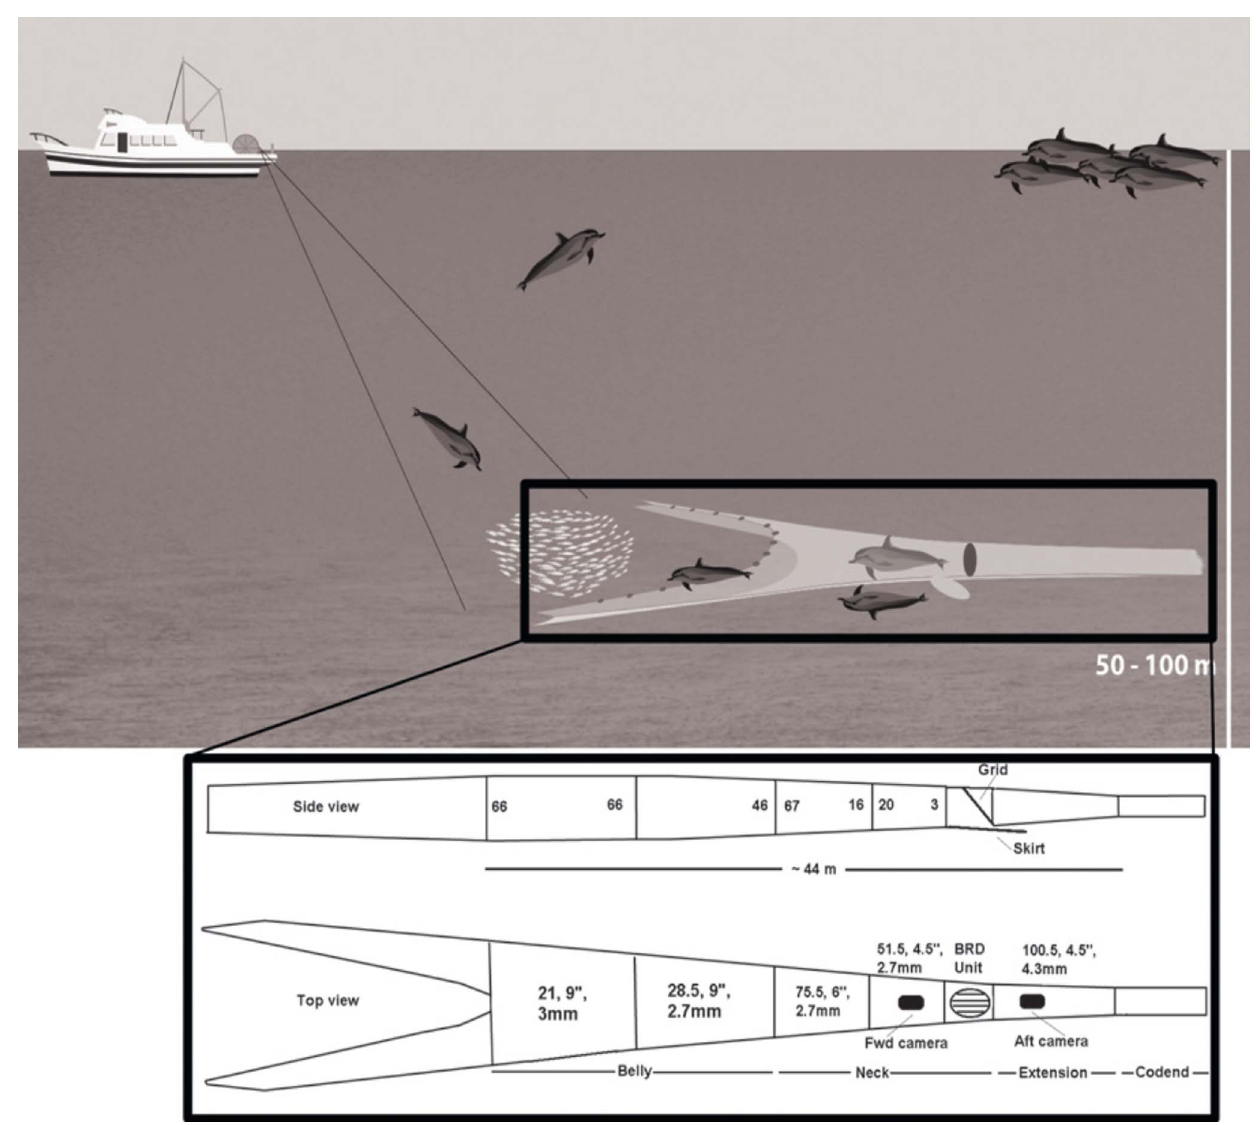
Figure 2. Schematic of trawler and trawl net on or near the seabed. Also illustrated are the typical positions of dolphins in and around the net, as well as following the trawler on the surface. The detailed net diagram represents the typical net specifications used in the Pilbara Trawl Fishery in 2008 and 2009, showing the side and top views, location of the Bycatch Reduction Device and the skirt covering the escape hatch. The lengths of the different panels are given as number of meshes, mesh length (in inches) and diameter of twine (in mm). In the side view, the height of each panel is given as the number of meshes. Diagram not to scale. Modified from Stephenson et al. [29] and Jaiteh et al. [35] following plans by H. McKenna for the ‘Magnet Box Diamond Net’ with short